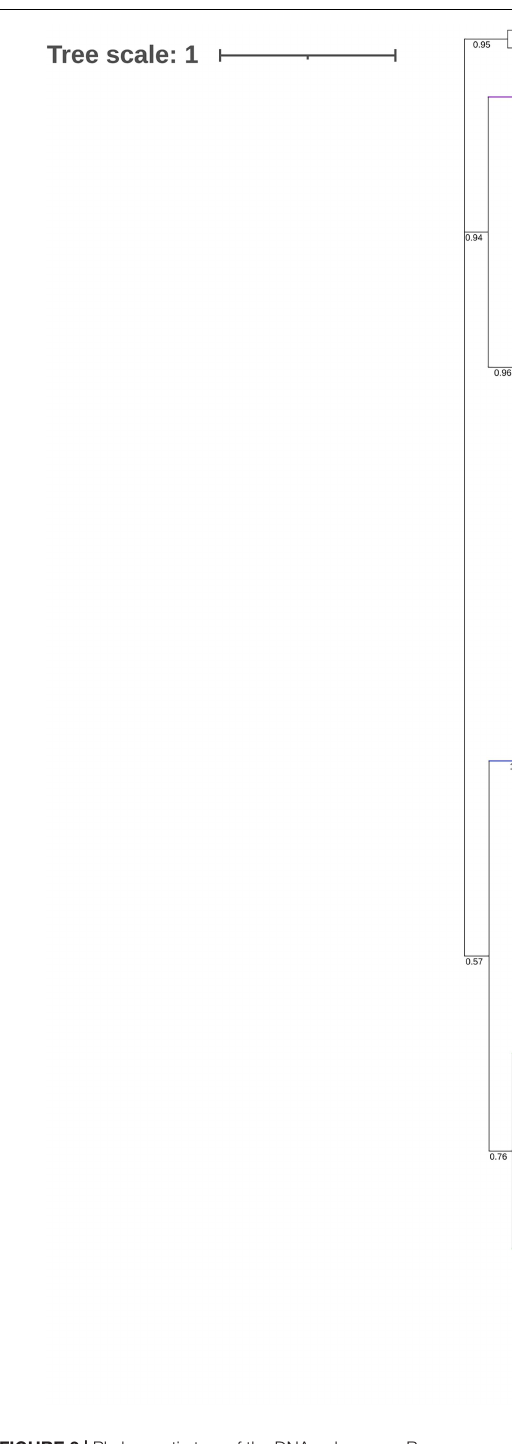
Frontiers in Microbiology |